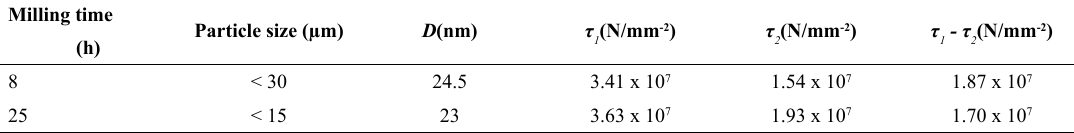
) and resistance stress (τ 1